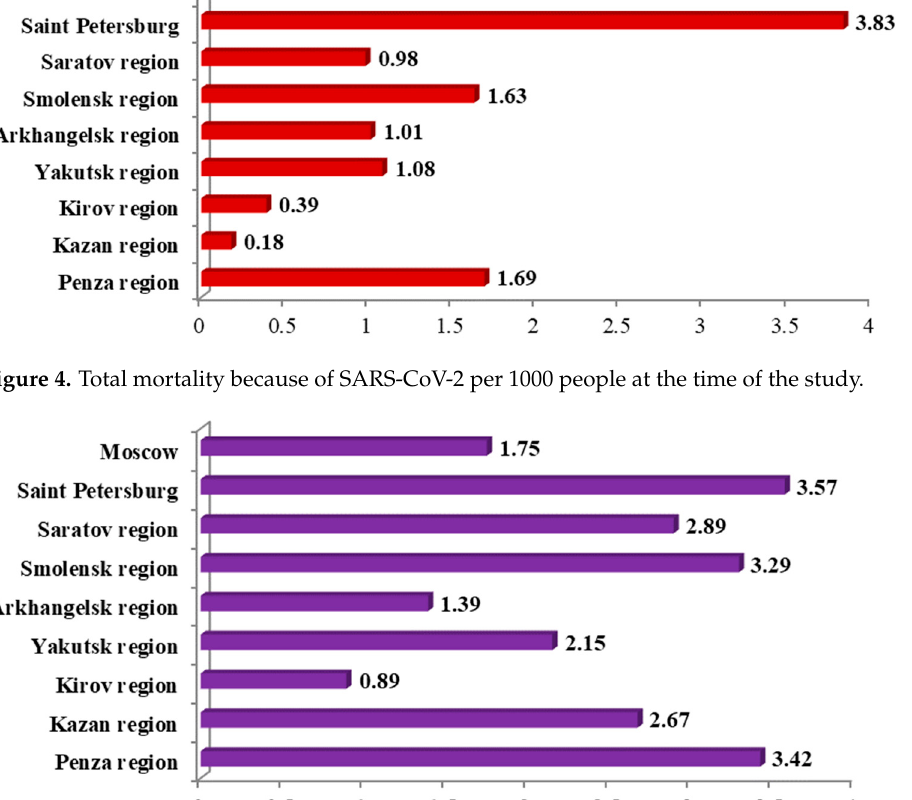
Figure 5. Lethality because of SARS-CoV-2 at the time of the study. figure was 52.3%.